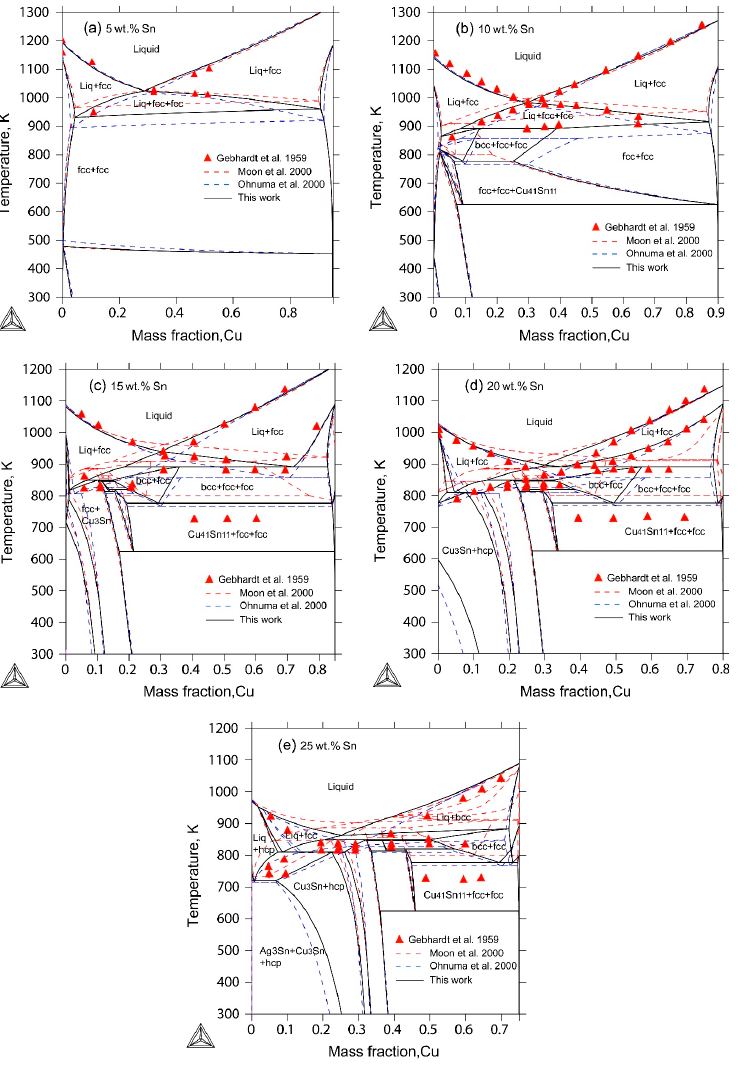
Figure 6. Calculated vertical sections of the Ag-Cu-Sn ternary system with the experimental data from [18] and the calculated results from [21,24]. ( a ) 𝑤 (cid:3020)(cid:3041) = 5 % ; ( b ) 𝑤 (cid:3020)(cid:3041) = 10 % ; ( c ) 𝑤 (cid:3020)(cid:3041) = 15 % ; ( d ) 𝑤 (cid:3020)(cid:3041) = 20 % ; ( e ) 𝑤 (cid:3020)(cid:3041) = 25 % . Figure 7 is the calculated enthalpies of mixing of the liquid Ag-Cu-Sn alloys at 773 K, 973 K and 1173 K (referenced states: liquid Ag, liquid Cu and liquid Sn) along different cross sections ( 𝑥 (cid:3002)(cid:3034) :𝑥 (cid:3004)(cid:3048) = 1:3, 𝑥 (cid:3002)(cid:3034) :𝑥 (cid:3004)(cid:3048) = 3:1,𝑥 (cid:3002)(cid:3034) :𝑥 (cid:3004)(cid:3048) = 1:1 ) with the experimental data measured by Luef et al. [30] and the calculated results [21,24,28]. The calculated results (solid line) at 1173 K in this work fit well with the experimental data compared with the previously calculated results (dashed lines) [21,24,28]. The calculated results by Gierlotka et al. [28] have a good fit with the experimental data at 973 K, and show a slight deviation from the experimental data at 773 K. Nonetheless, good agreements are achieved be- tween the calculated enthalpies of mixing of the liquid Ag-Cu-Sn alloys and the experi- mental data at 1173 K in this work, which are better than the calculated results [21,24,28].